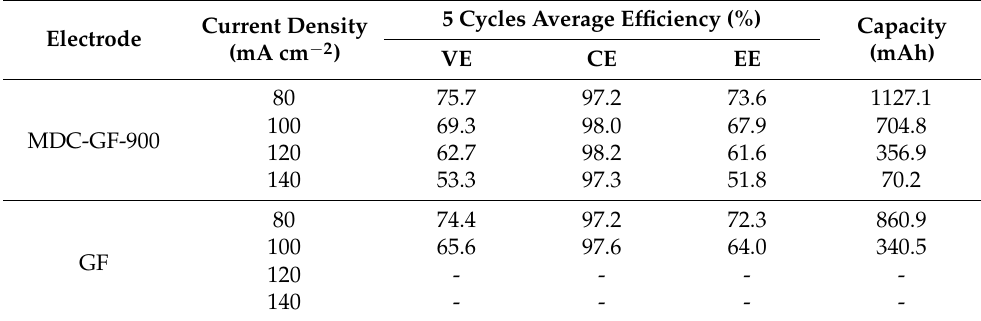
Table 1. The VE, CE, and EE of VRFB single-cell tests with MDC-GF-900 and GF electrodes at 80, 100, 120, 140 mA cm − 2